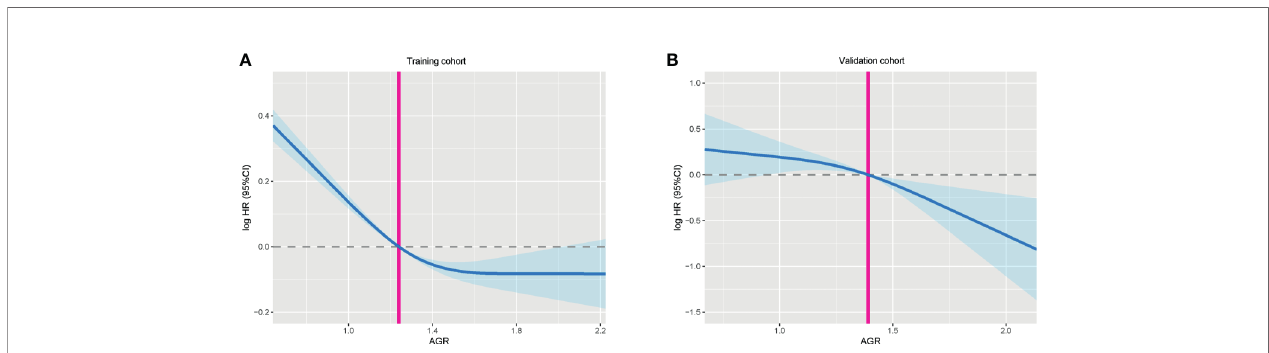
FIGURE 2 | The association between AGR (continuous) and hazard risk of overall survival in training cohort (A) and validation cohort (B) . The splines were adjusted by gender, age, BMI, TNM stage, surgery, radiotherapy, chemotherapy, family history, hypertension, diabetes, smoke, and alcohol. AGR, albumin – globulin ratio; BMI, body mass